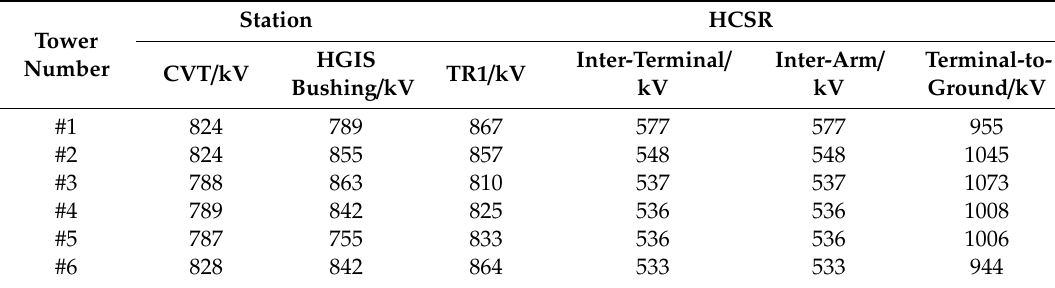
Figure 6. Inter-terminal and inter-arm overvoltage of the HCSR. Table 8. Overvoltage of the equipment in current sharing state.